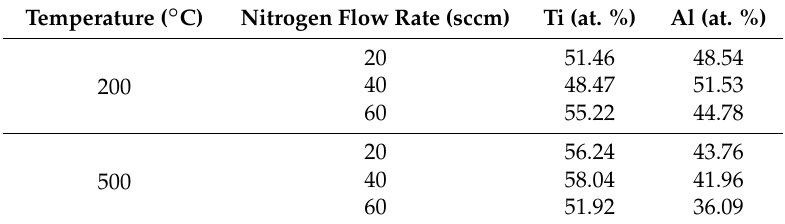
Table 2. Chemical composition of the Ti-Al-N coatings by means of WDS